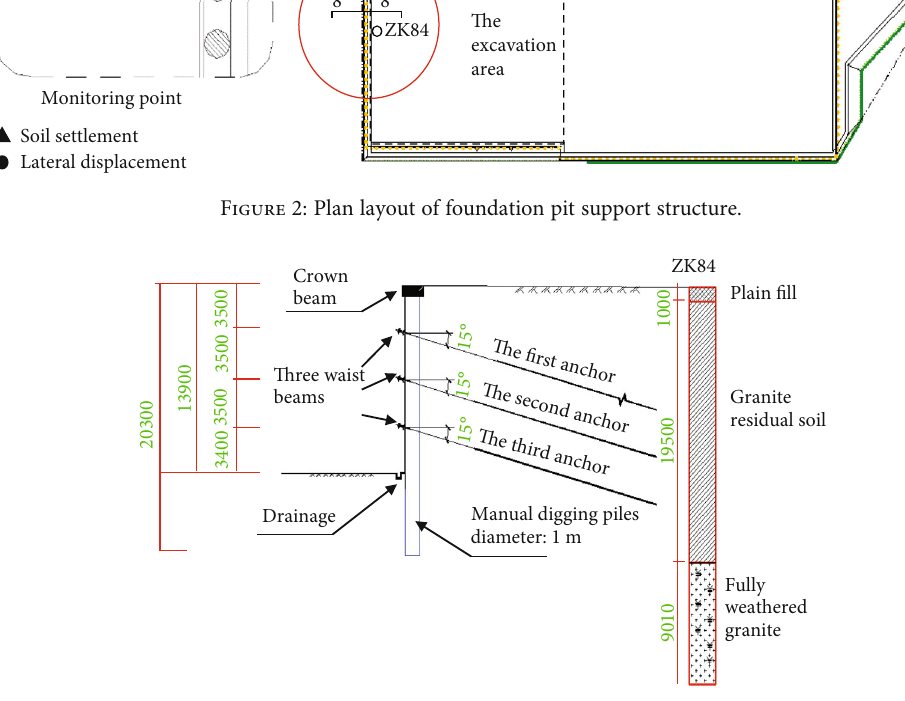
Figure 3: Cross-sectional view of 8-8 of physical model used in the study. Table 1: The detailed information of soil used in the present